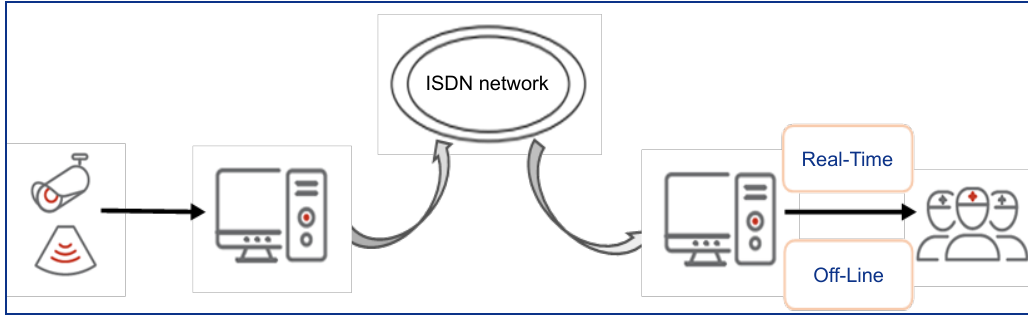
Figure 1 Schematic diagram of remote echocardiographic service using ISDN in real-time or offline mode.